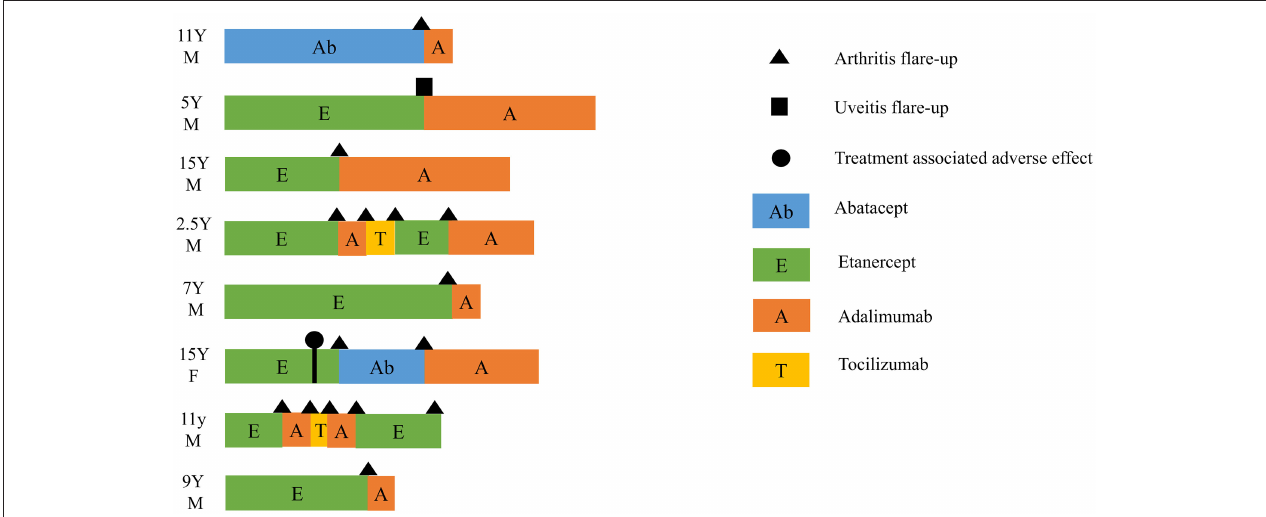
FIGURE 2 | Switch between biologics in eight patients who had flare-up during biologics tapering. Triangle, flare-up with presentation of arthritis; square, flare-up with presentation of uveitis; circle, treatment-associated adverse effect (pulmonary tuberculosis infection); Ab, abatacept; E, etanercept; A, adalimumab; T, tocilizumab; Y, years old; M, male; F,